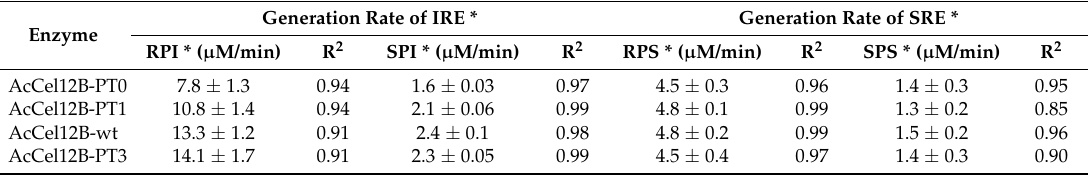
Table 3. The rate distribution of reducing ends in time course of RAC hydrolysis. Generation Rate of IRE * Enzyme